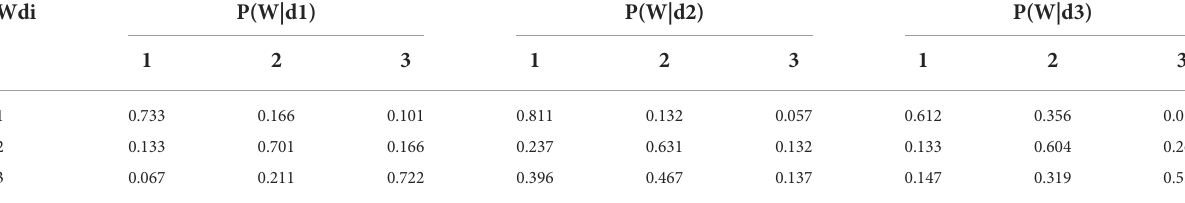
TABLE 5 Conditional probability distribution of d1 , d2 , d3 .